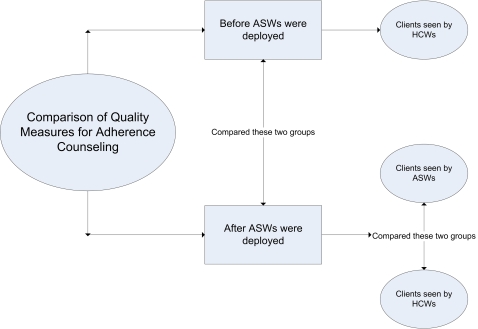
Figure depicting the groups compared for Quality Measures.Various quality measures for HCWs and ASWs were compared for clients who were counseled before and after ASWs were introduced in the facilities. Another comparison was conducted to compare ASWs and HCWs after the introduction of ASWs.